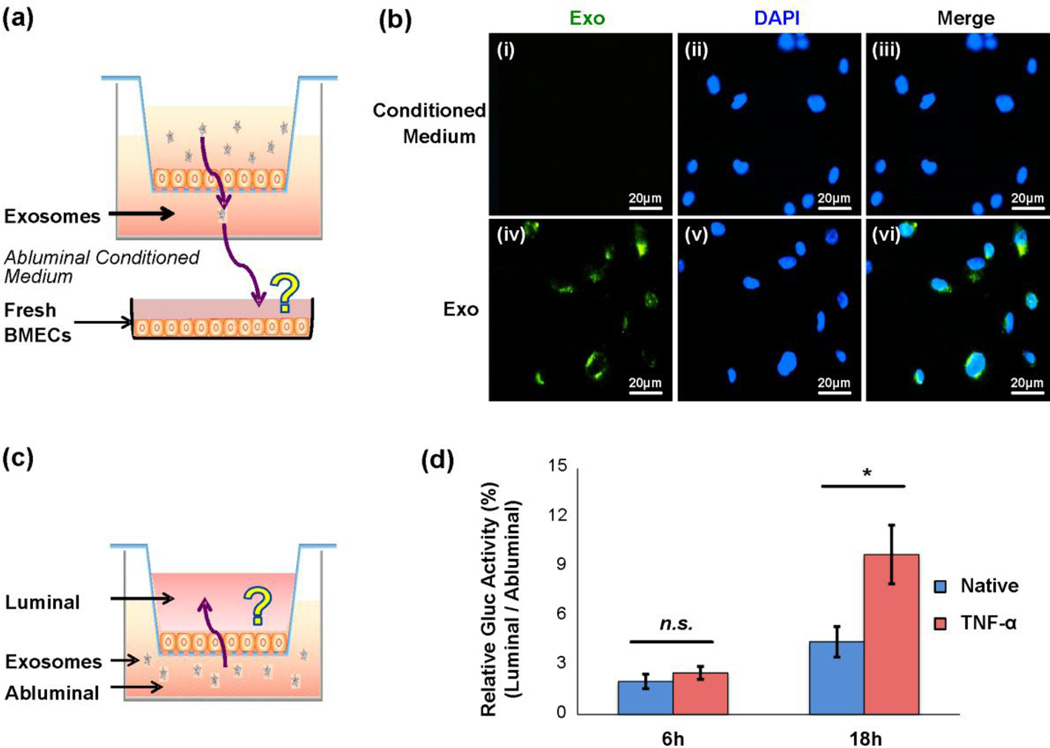
Validation of exosome crossing BMEC monolayers(a) Exosomes can cross the BMECs carrying hGluc in vitro. hGluc-Lact exosomes were labeled with the lipophilic dye PKH67, and were added to the luminal chamber of the transwell. Conditioned medium from abluminal chambers were collected and then incubated with a monolayer of BMEC on coverglass to further confirm the hGluc activity observed from bioluminescence assay was directly from exosomes. (b) Exosomes uptake by BMECs. hGluc conditioned medium of abluminal chamber stained with PKH67 was used as a control. Scale bar: 20 µm. (c) The schematic representation of exosome migration from abluminal chamber to the luminal chamber under native and TNF-α-treated conditions. (d) Quantitative analysis of exosome migration from abluminal to luminal chamber at 6 hours and 18 hours. Relative bioluminescence activity suggested that there was no significant difference between native and TNF-α-treated conditions at 6 hours, whereas the relative bioluminescence activity is significant higher in BMECs treated with TNF-α at 18 hours. Relative Gluc Activity = (luminal chamber signal - native exo signal) / (abluminal chamber signal - native exo signal) × 100%. Error bar: mean ± SEM. n.s., not significant and *P < 0.05.